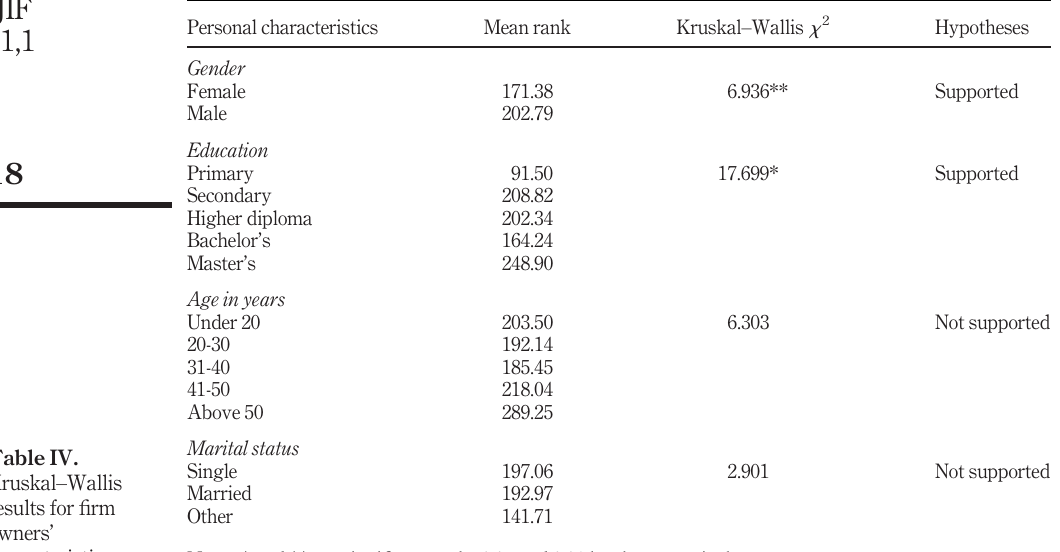
Table IV. Kruskal – Wallis results for fi rm owners ’